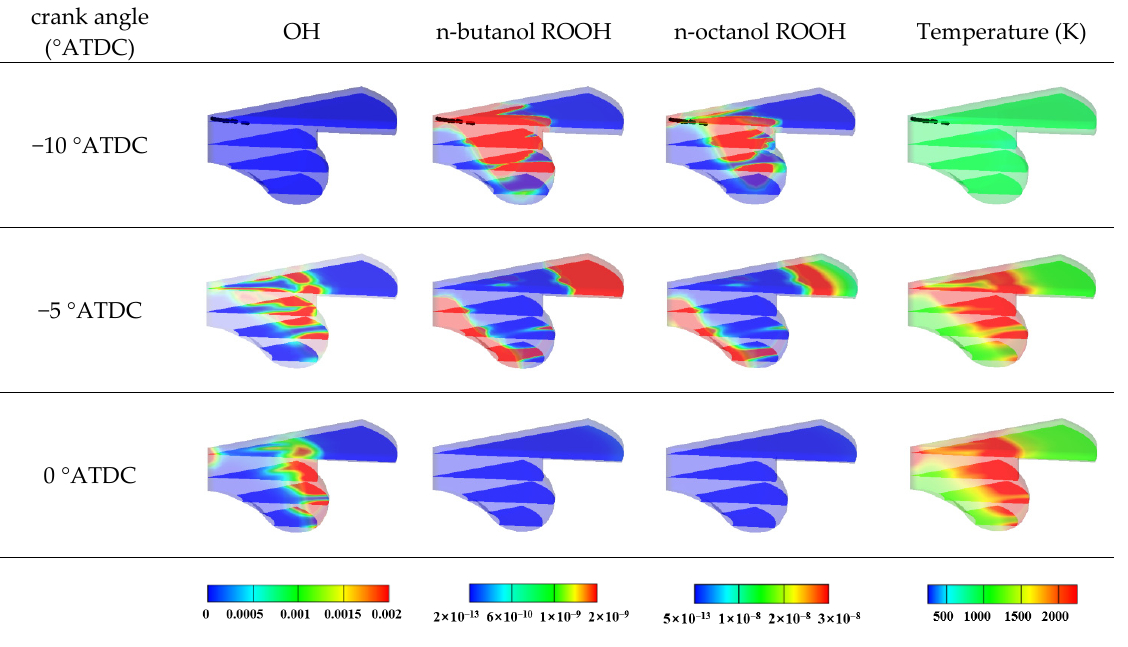
Figure 6. Comparison of the concentration distribution of OH, ROOH, and temperature under B20 working condition.